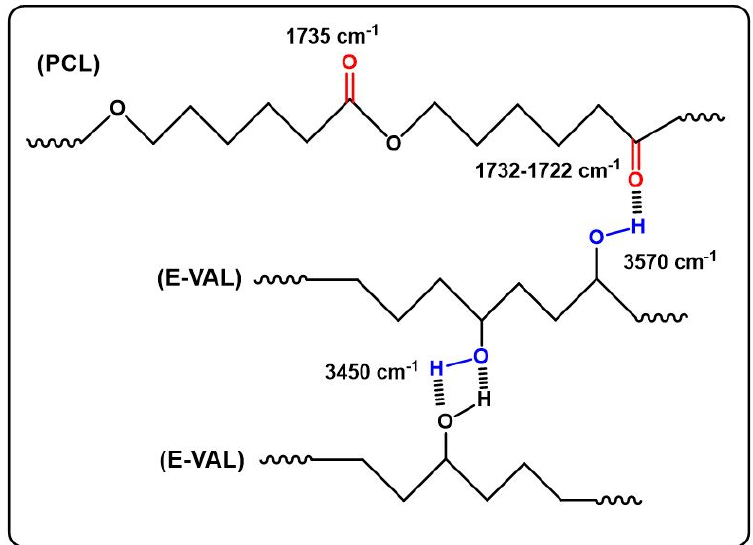
Figure 1. FTIR spectra of poly(ethylene- co -vinyl alcohol) (E-VAL), poly( ε -caprolactone) (PCL) and their blends containing (B) 90, (C) 75, (D) 50, (E) 25 and (F) 10 wt% E-VAL.